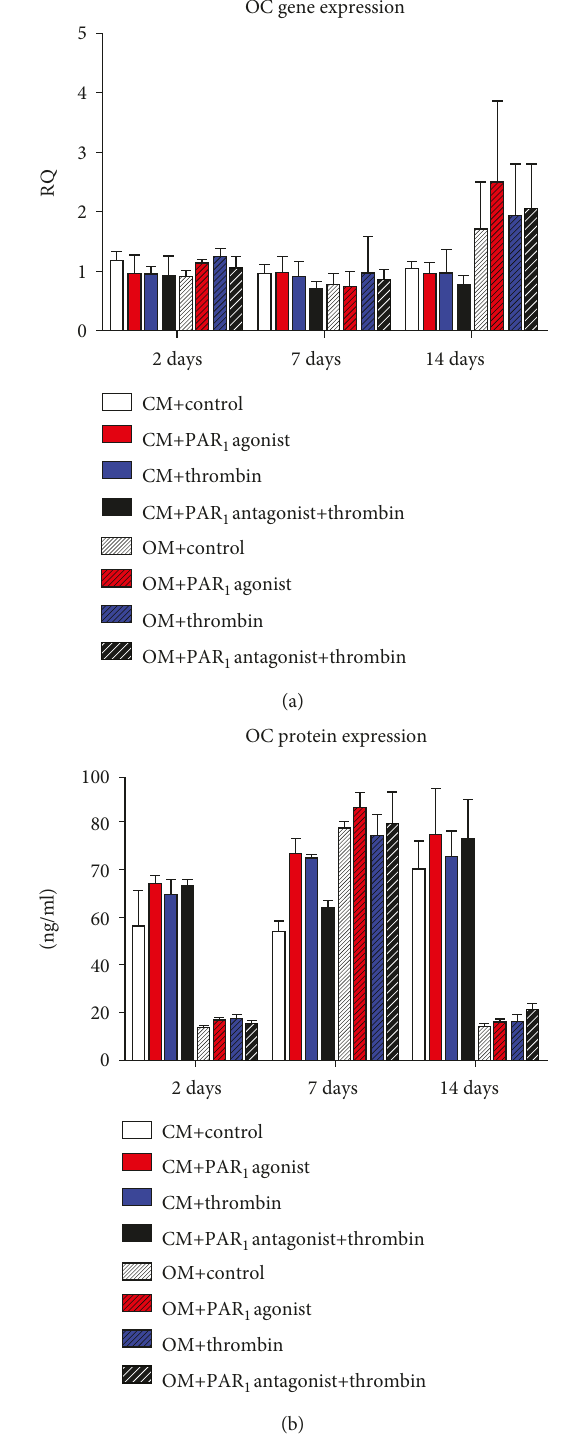
Figure 8: E ff ects of PAR activation on OC protein and gene 1 expression at 2, 7, and 14 days. Values are presented as mean and SEM; n = 3